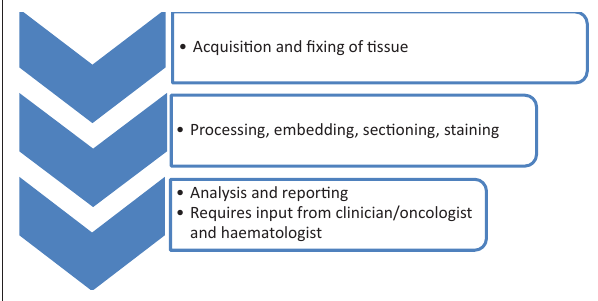
FIGURE 1: Steps involved in obtaining histologic diagnosis, highlighting the interdisciplinary nature of the diagnostic process.